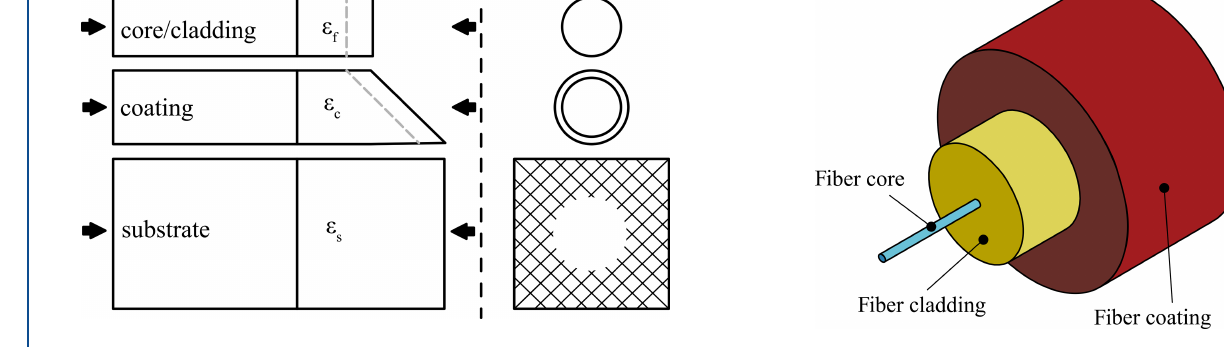
Figure 2. Structure of a